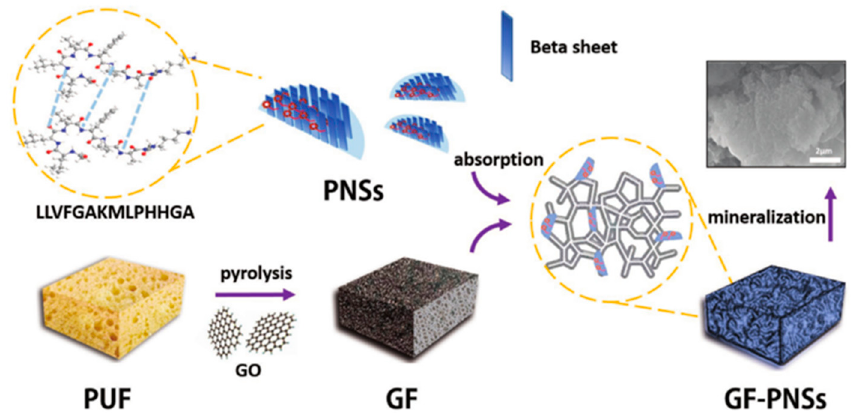
Figure 12. Two-dimensional peptide nanosheets (PNSs) by molecular tailoring: a schematic presentation of 2D peptide self-assembly and the biomimetic fabrication of 3D graphene foam (GF)-PNS-HA minerals. Reprinted with permission from [164]. Copyright 2018 WILEY-VCH.